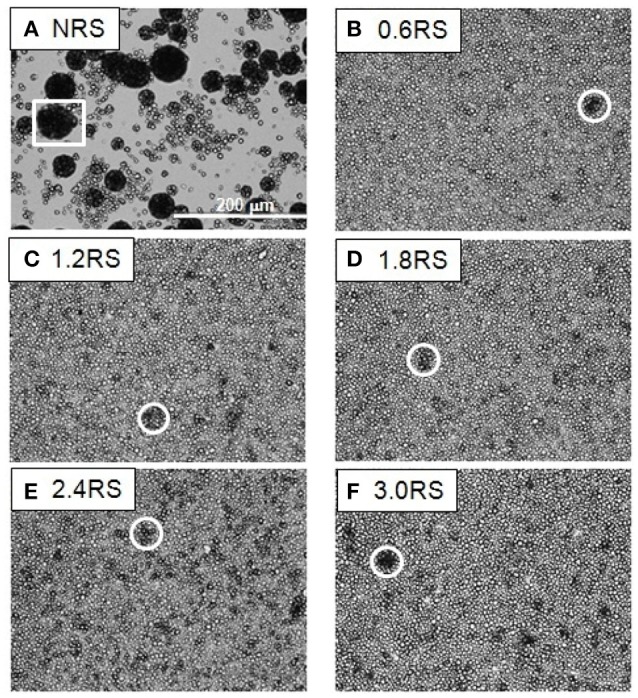
Optical microscope images of films of native and OSA modified starch particles compressed to ∏ = 25 mN/m at air/water interfaces. The white square shows an example of the large aggregates formed by the NRS particles. The white circles show examples of dark patches of closely packed OSA modified particles or aggregates in the films.